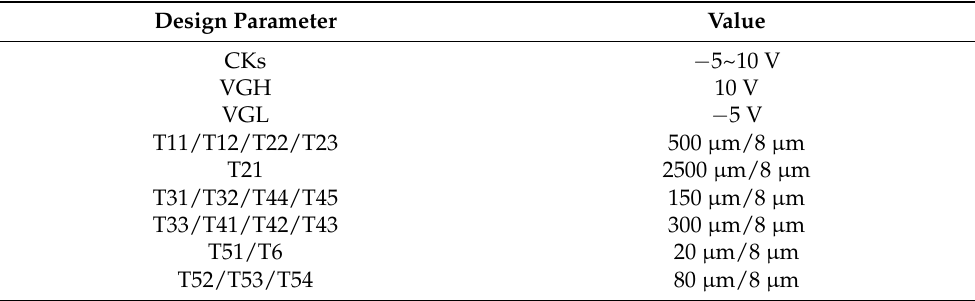
Table 1. The parameters of the proposed SR circuit. Design